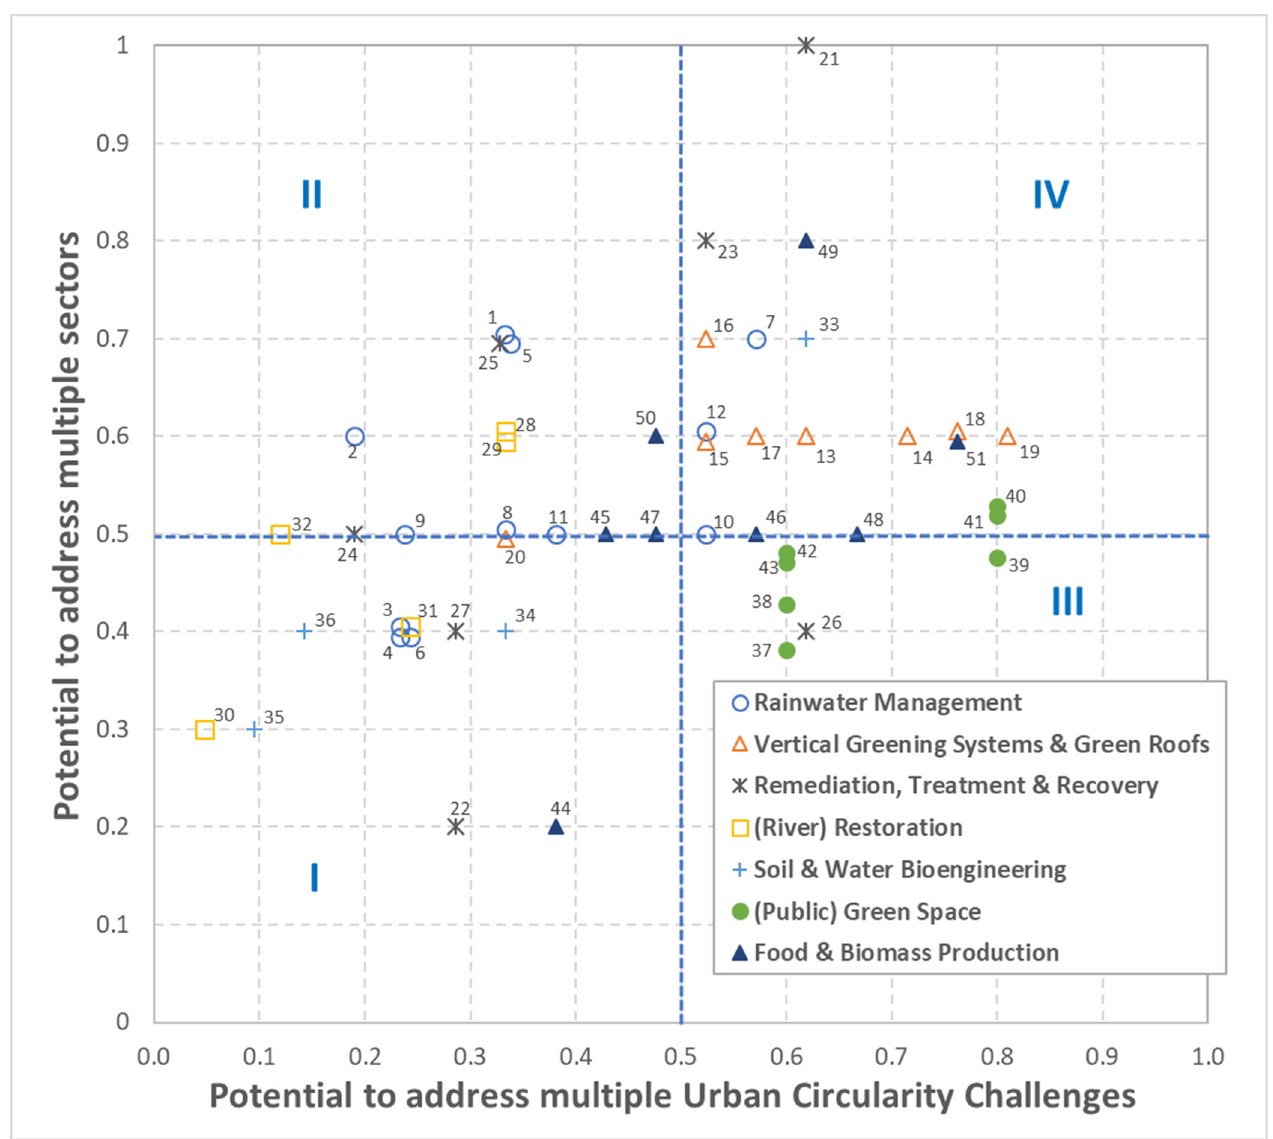
Figure 5. Potential of NBS units and interventions (NBS_u/i) to address multiple Urban Circularity Challenges (UCCs) and sectors. The numbers refer to numbers of the NBS_u/i in Table 1, and the different symbols refer to the categories of NBS_u/i [13]. NBS_u/i in quadrant I have lower potential to address multiple UCCs and sectors compared to NBS_u/i in quadrant IV.